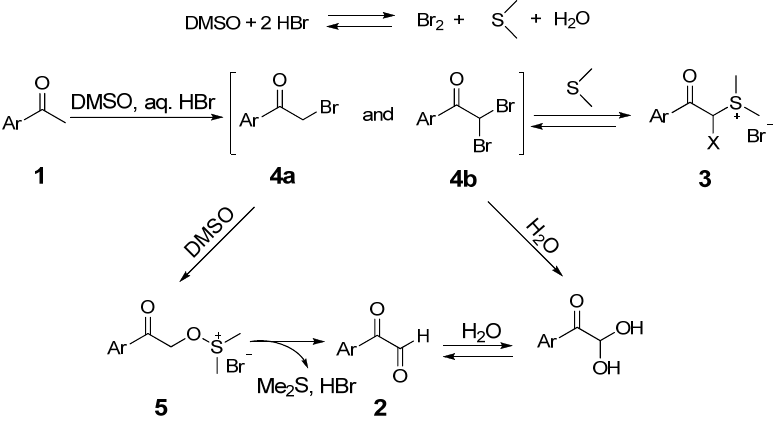
Table 2. Optimization of reaction conditions for synthesis of sulfonium salt 3a a . Molar Ratio Entry Time (h) Temp. (°C) Yield (%) b Methyl Ketone/HBr 1 1:3 6 40 41 2 1:3 10 40 69 1:3 12 40 56 1:3 10 55 45